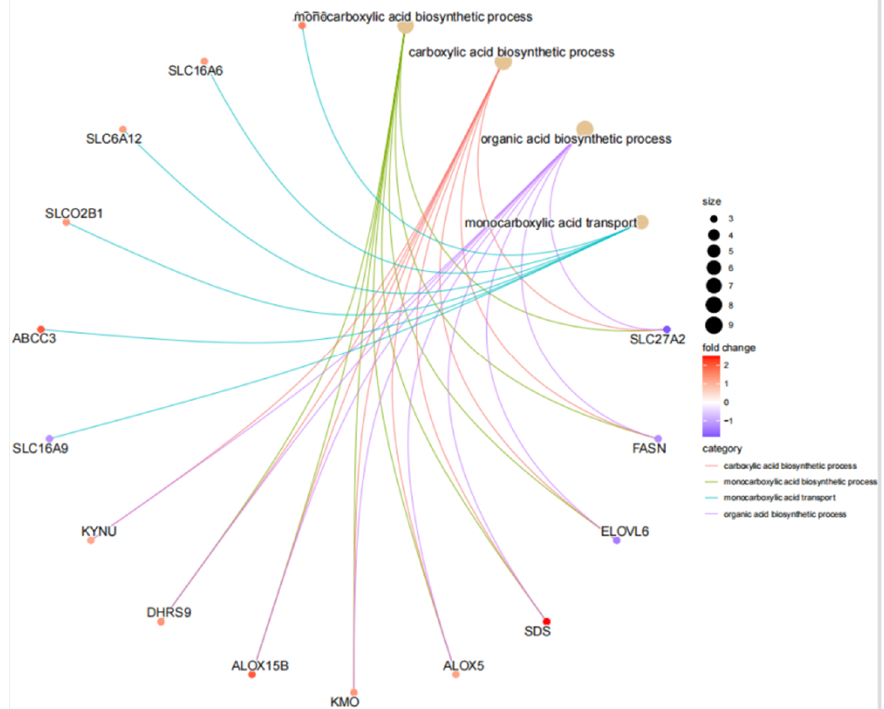
Figure 5. Circle graph from the gene ontology (GO) enrichment analysis of the differentially expressed genes of metabolism-related proteins (MP−DEGs).